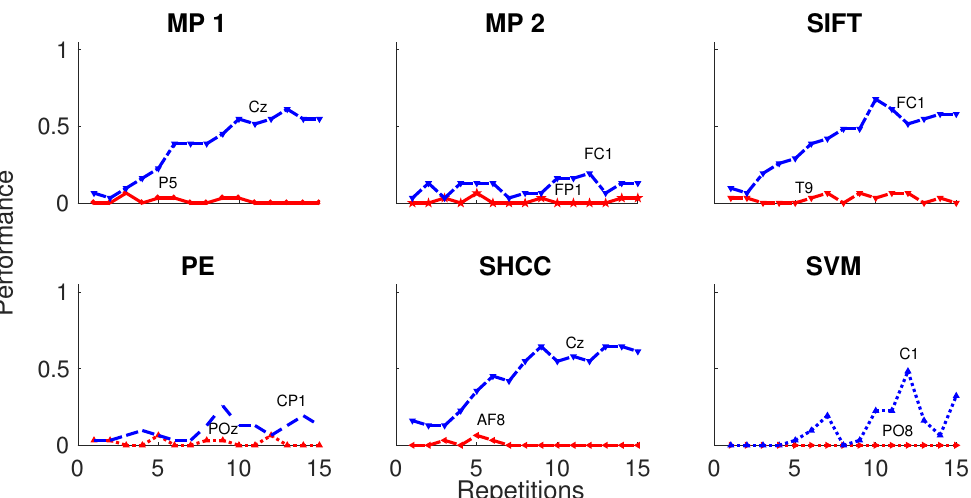
Figure 12. Speller performance obtained for the Dataset IIb of the BCI Competition II (2003) for each one of the algorithms. An offline BCI Simulation is performed using the first 42 trials as training and the remaining 31 as testing. The horizontal axis show the number of intensification sequences, from 0 to 15 for this dataset, while the vertical axis show the performance